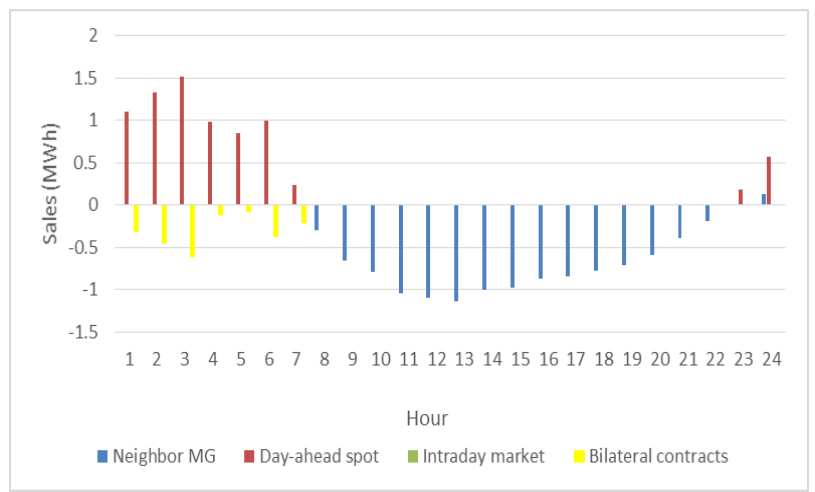
Figure 8. Negotiation scheduling for MGCC 1 resulting from the proposed methodology.